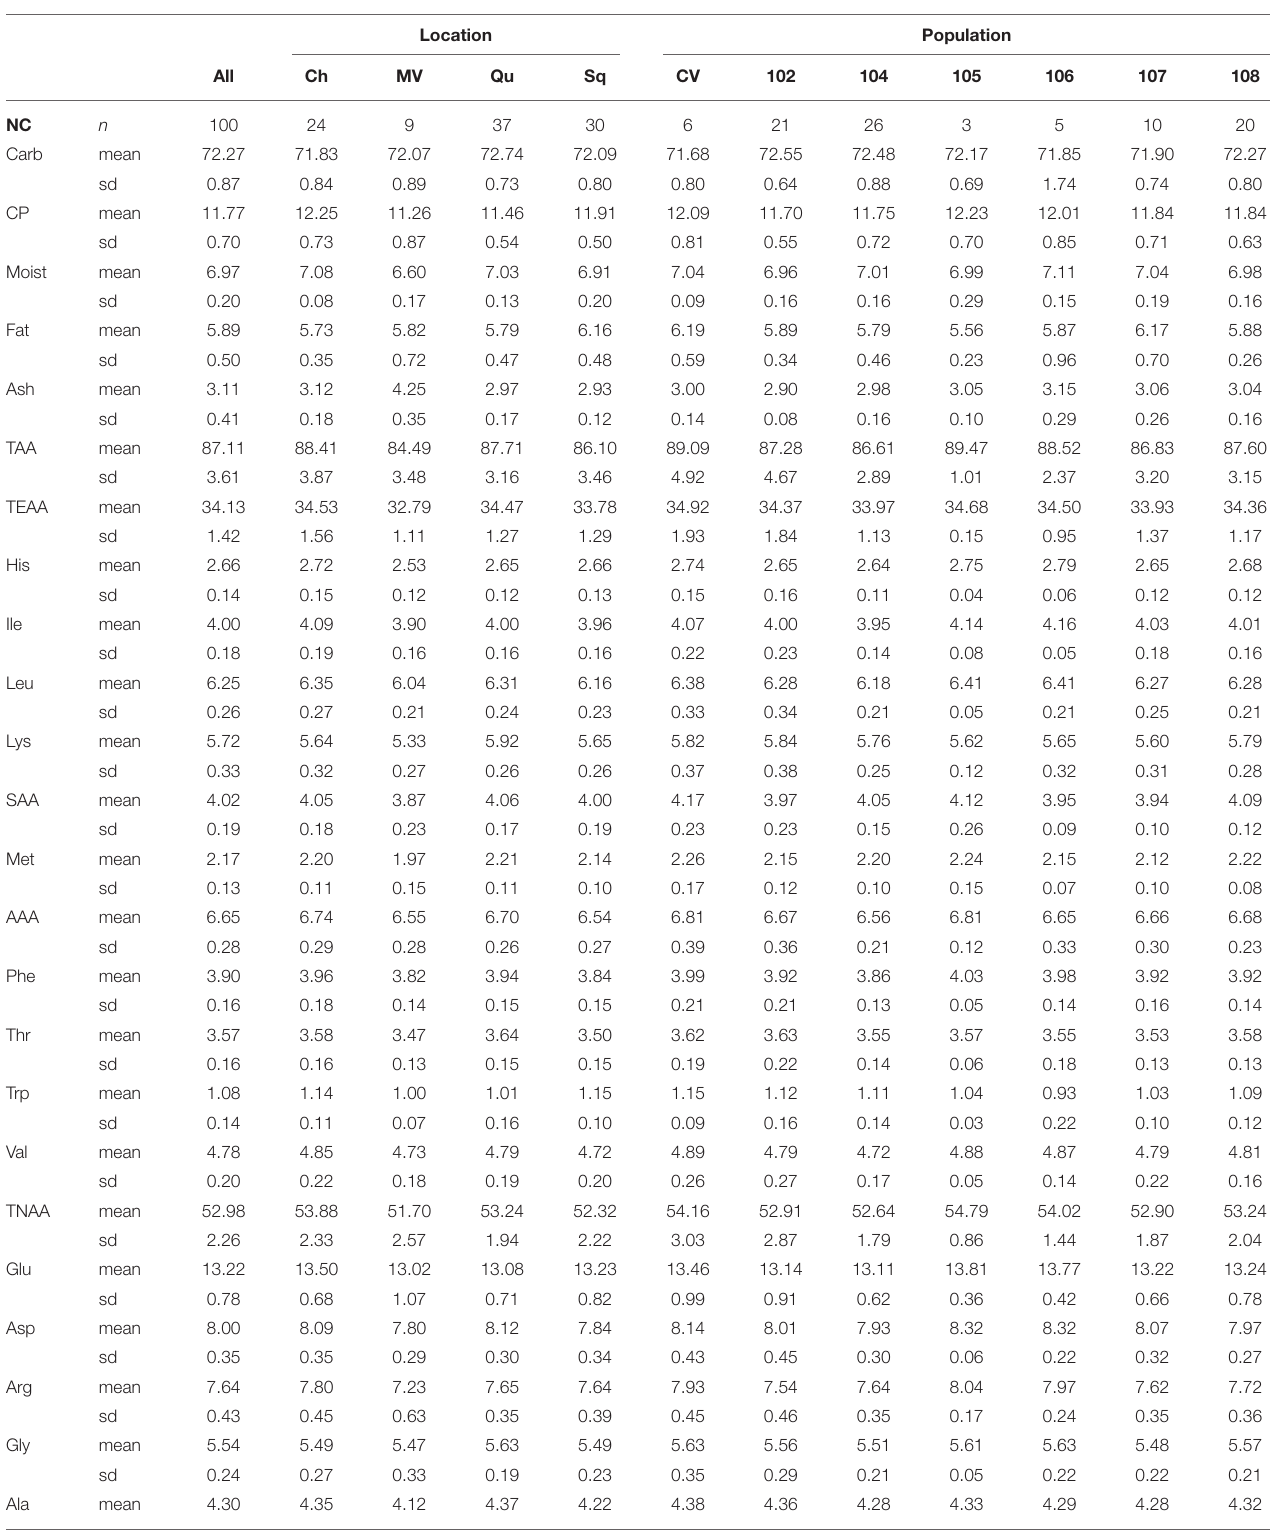
TABLE 5 | Mean and standard deviation (sd) values for the nutritional components (NC) analyzed are reported for all samples ( n = 100), and the samples grouped by location and population (i.e., seed source). Location